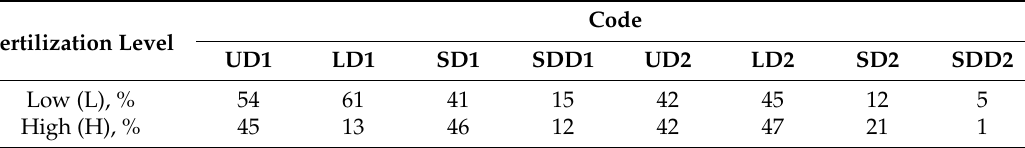
Table 5. Plant uptake efficiency of nitrogen (NUE) for untreated digestate (UD), liquid digestate (LD), solid digestate (SD), and solid digestate dried (SDD) at low (L) and high (H) level of fertilization; code 1 and 2 means digestate from biogas plant 1 and biogas plant 2,